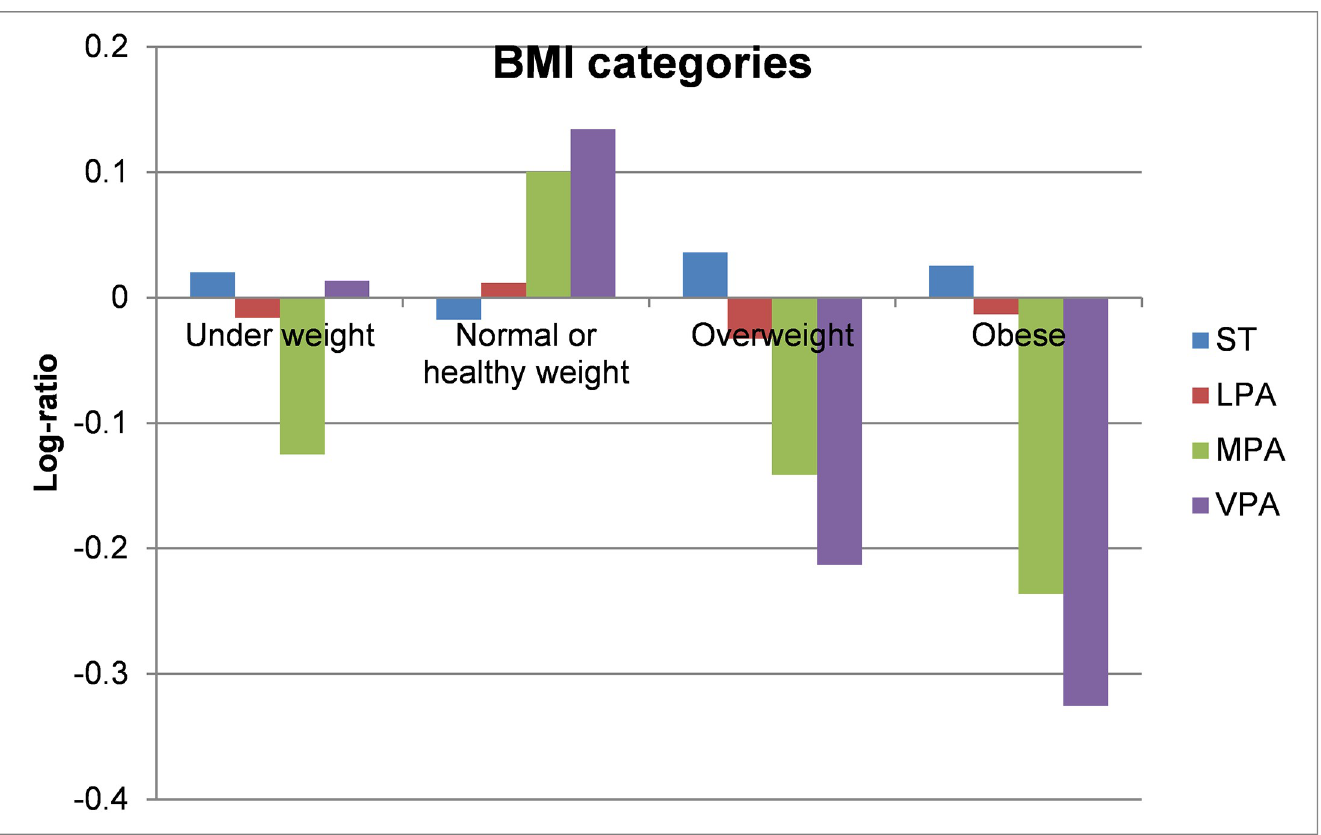
Fig 1. Compositional geometric mean bar plots comparing the compositional mean of the entire sample with the compositional mean of underweight, normal weight, overweight, and obese subgroups for sedentary time (ST), light-intensity physical activity (LPA), moderate-intensity physical activity (MPA), and vigorous-intensity physical activity (VPA). BMI = body mass